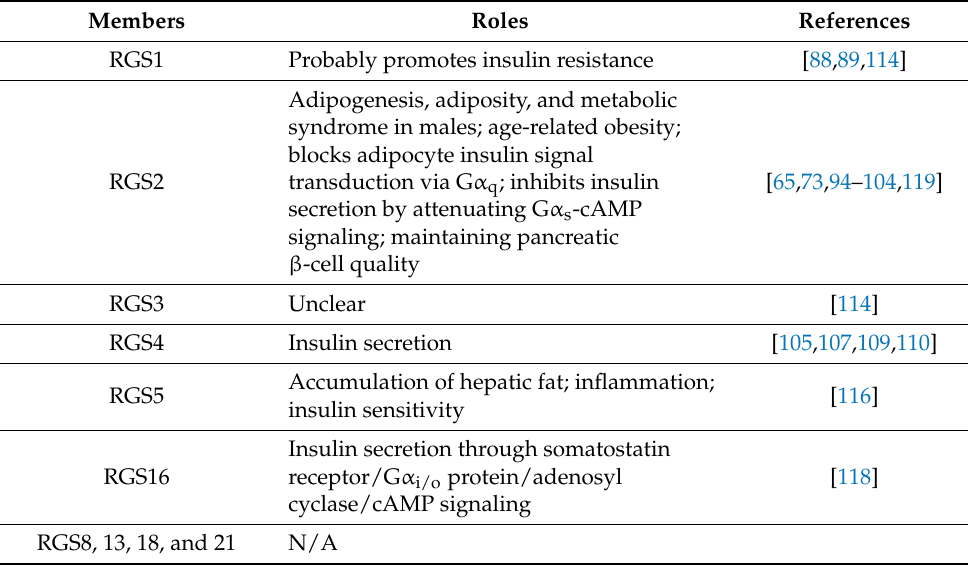
Table 3. Summary of R4 RGS subfamily members and their roles in